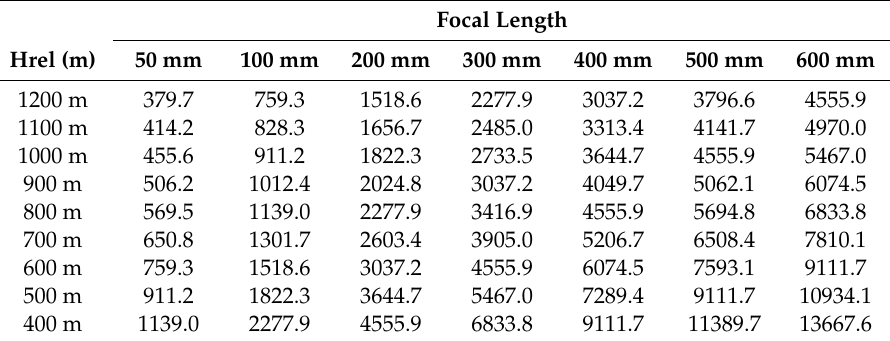
Table 2. Longest shutter speed without motion blur (1 / x s) as a function of relative flight altitude and focal length at 160 km / h ground speed. Hrel: altitude above ground.